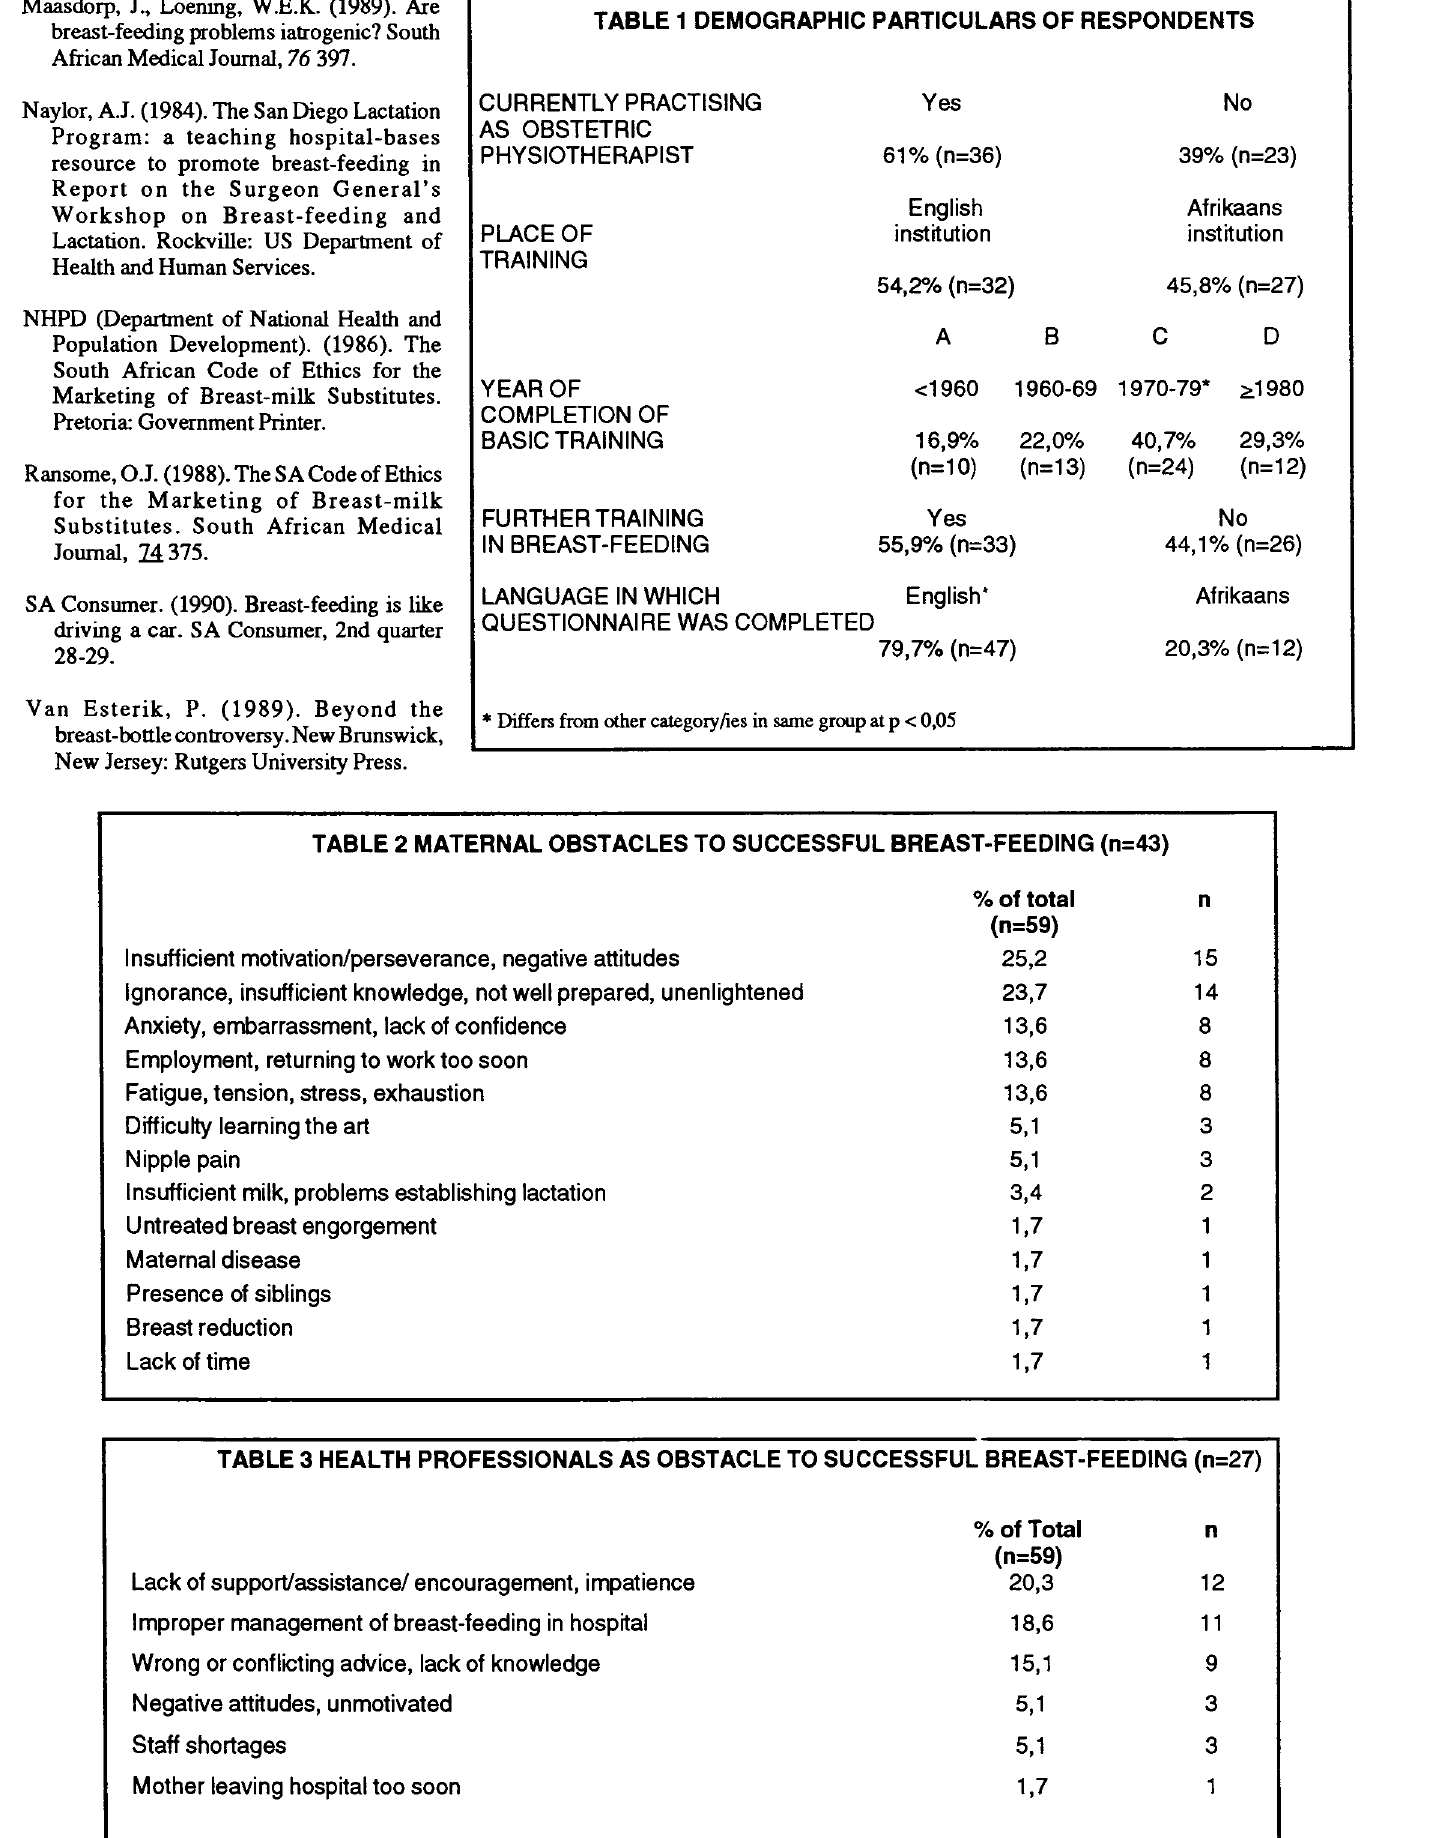
TABLE 3 HEALTH PROFESSIONALS AS OBSTACLE TO SUCCESSFUL BREAST-FEEDING